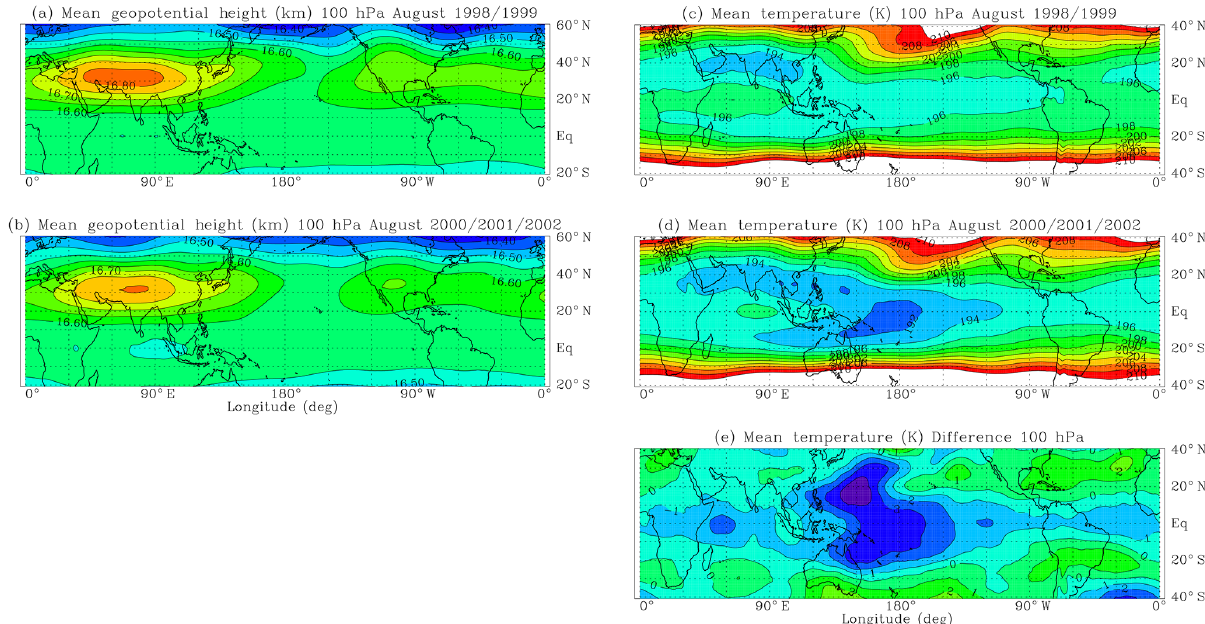
Figure 9. Longitude–latitude sections of (left) geopotential height (km) and (right) temperature (K) at 100hPa averaged in August 1998 and 1999 (a, c) and 2000, 2001, and 2002 (b, d) as well as the difference between the two (e) estimated from the ERA-Interim data set. Note the difference of latitudinal range between the left- and the right-hand